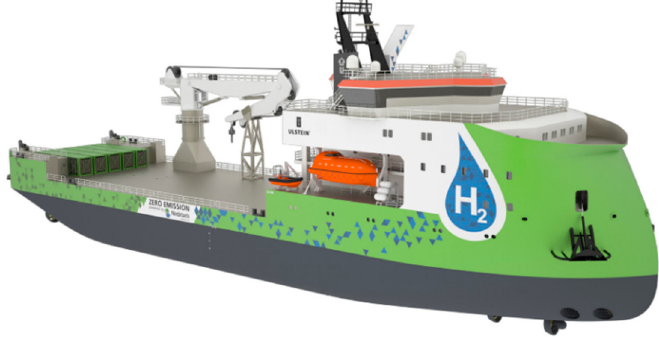
Figure 21. The conceptual design of “Ulstein SX190 Zero Emission DP2” [107].